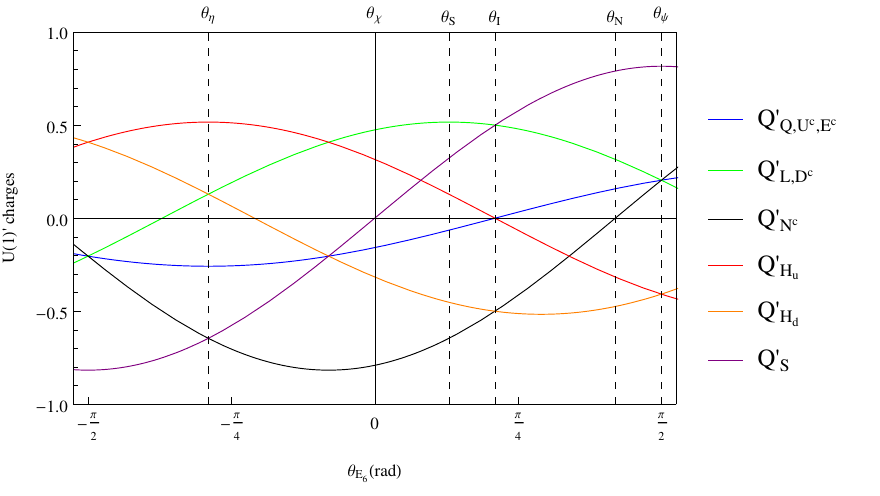
Figure 1. U(1) 0 charges of all the chiral super(cid:12)elds of the UMSSM as function of (cid:18) E 6 .